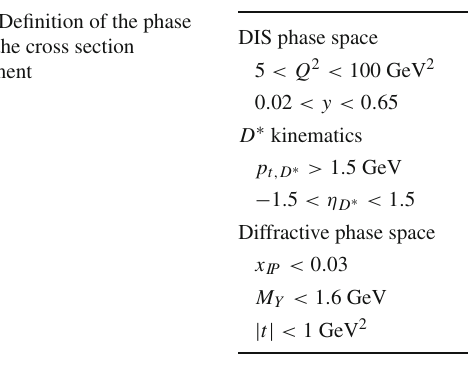
Fig. 3 The differential N ( D ∗ ) distributions obtained from (cid:10) m fits to the data and simulation as a function of Q 2 , y , log 10 ( x IP ) , z obs and η D ∗ . The data are represented with dots . The contributions of indi- vidual processes in the simulation, reweighted RAPGAP, are indicated